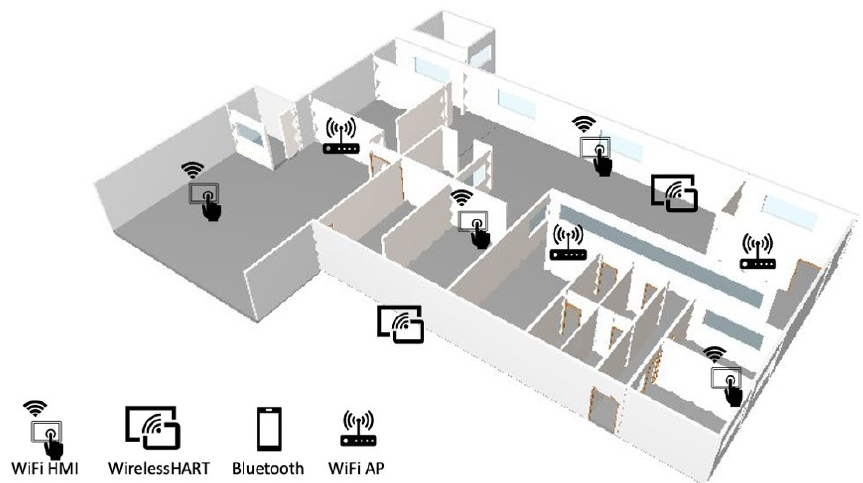
Figure 7. Simulation environment with the description of the different wireless devices present on the factory shop floor and in the surrounding spaces.